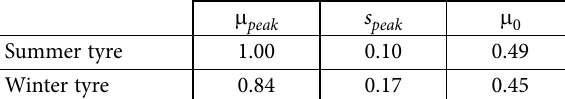
Figure 14. Adhesion characteristics m ( s ) for summer and winter